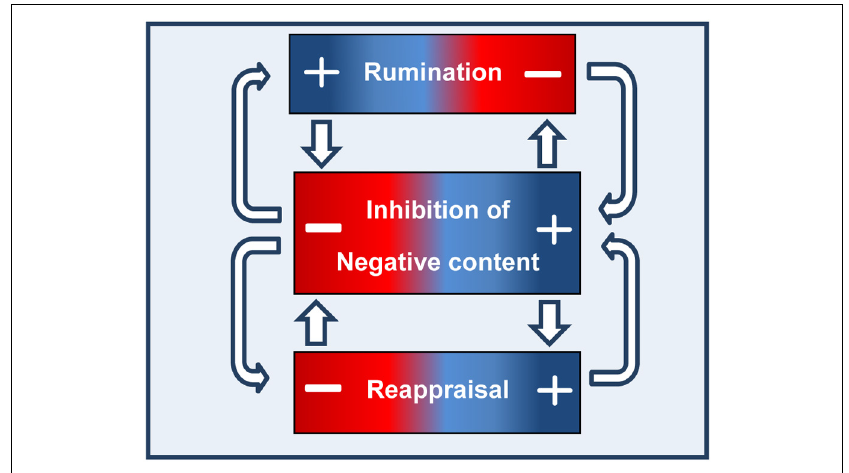
a trend toward improved inhibition of irrelevant negative content. Furthermore, those who were trained to inhibit negative stimuli reported reduced trait rumination following the training (Daches and Mor,